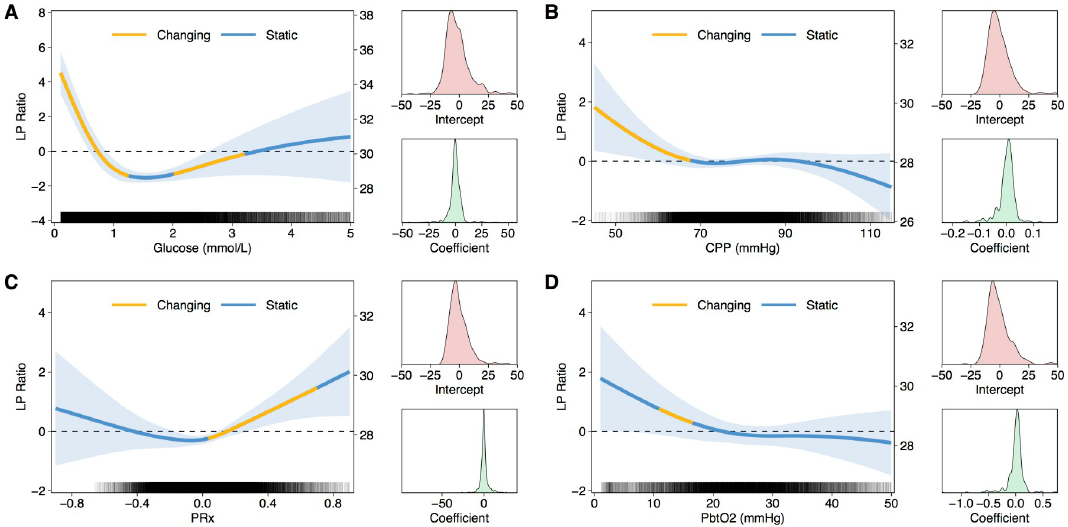
Fig 4. Relationship between lactate-pyruvate ratio (LPR) and other physiological parameters. In each panel a GAMM fit of glucose (A), CPP (B), PRx (C), and PbtO 2 (D) against LPR is plotted. On the left axis LPR is scaled to zero mean without the intercept term; on the right axis the scale includes the overall intercept. Shaded region indicates 95%CI for the fit. The regions of each curve highlighted in yellow indicate non-zero first derivative i.e. where the is significant change. Alongside each plot is the distribution of random effects for intercept and slope/coefficient. Rug plot within in each panel indicates density of data.